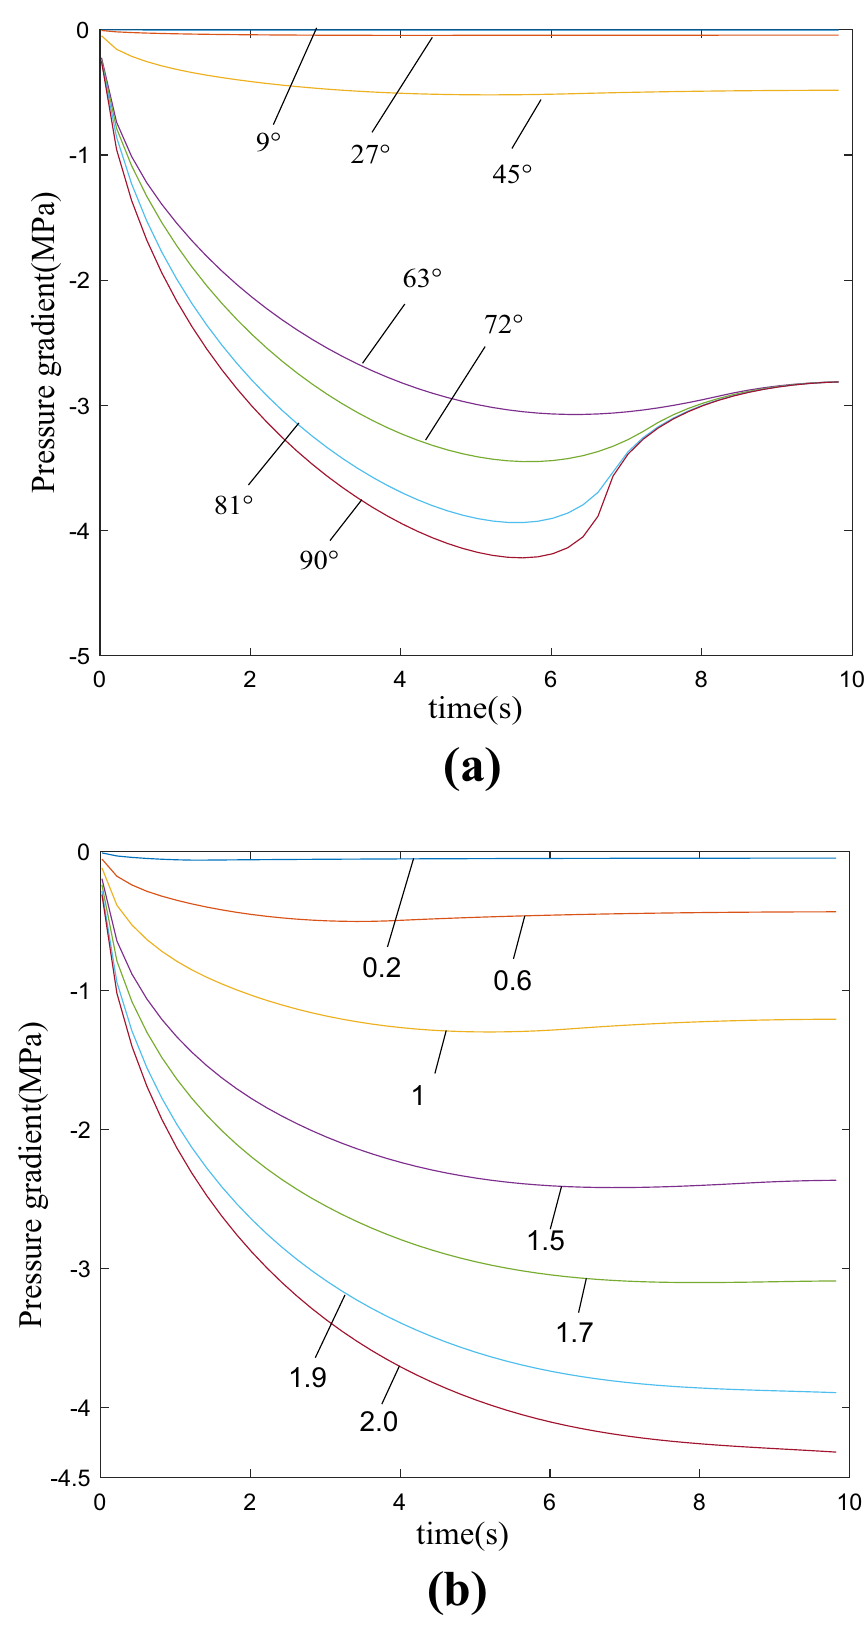
Figure 11. Curve of pressure gradient of u buffer tank with